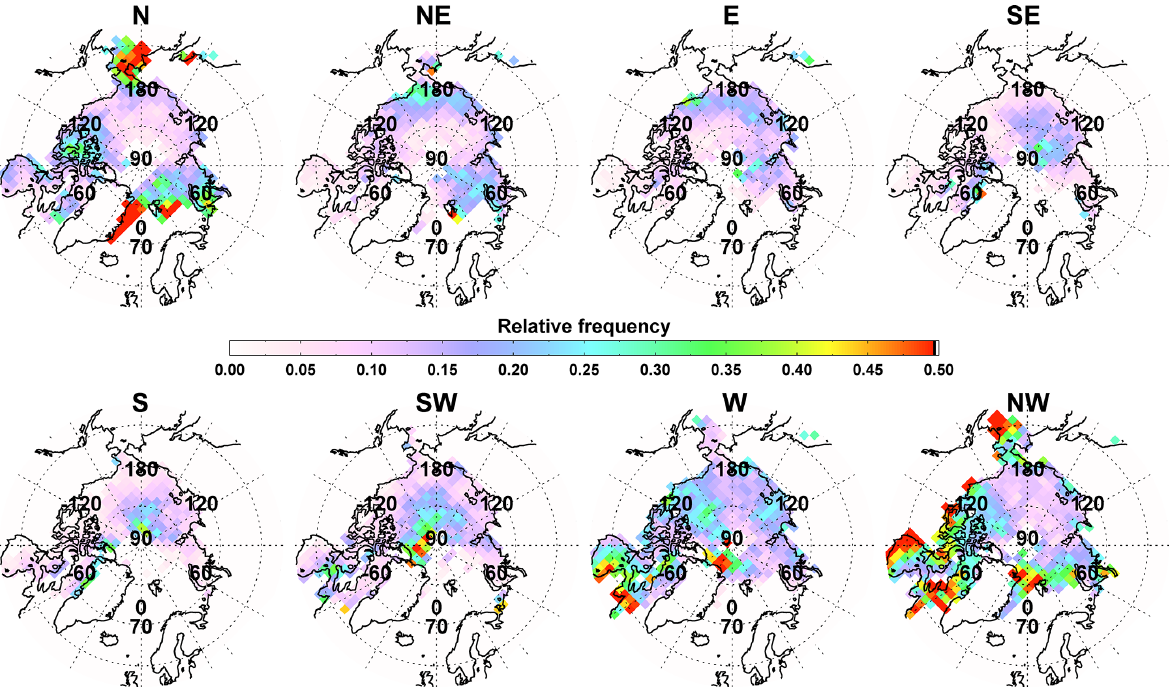
Figure 13. Relative frequency maps of surface-level wind direction for data with BrO enhancements over the Arctic during spring (March to April in 2008–2018). The frequency was calculated for the cases where the number of data points collected within the reference grid is greater than 20. The results are shown separately for different wind directions.